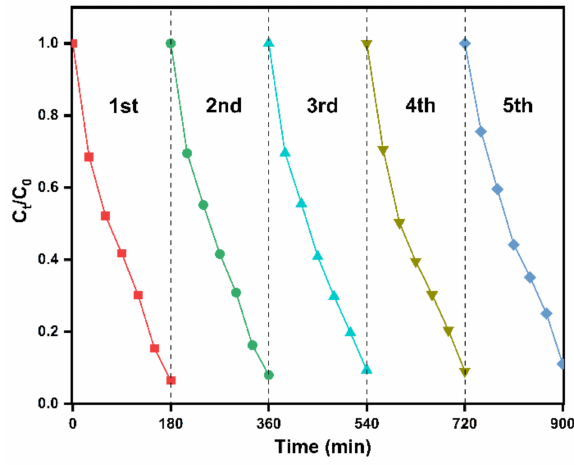
Figure 9. Reusability of photocatalytic activities experiment on 20BSCN photocatalysts.